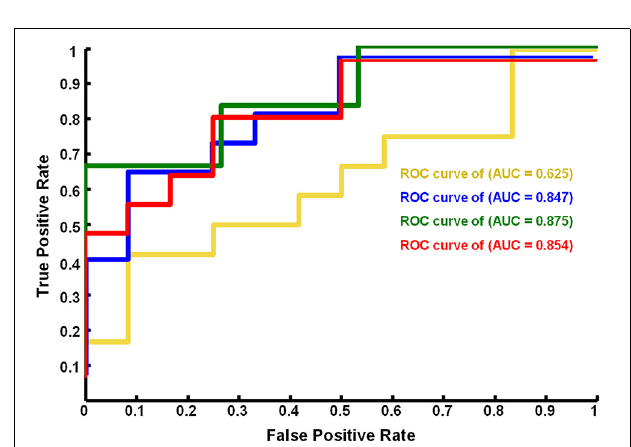
FIGURE 4 | Mean fALFF values of each brain region in the neural fALFF map with | Z | > 1 . 96 related to the EC and EO states. fALFF was calculated as the ratio of the ALFF value in the range of 0.01–0.08Hz to that of the entire frequency range (0–0.25Hz). The brain regions and corresponding modules are same to those in Figure 2